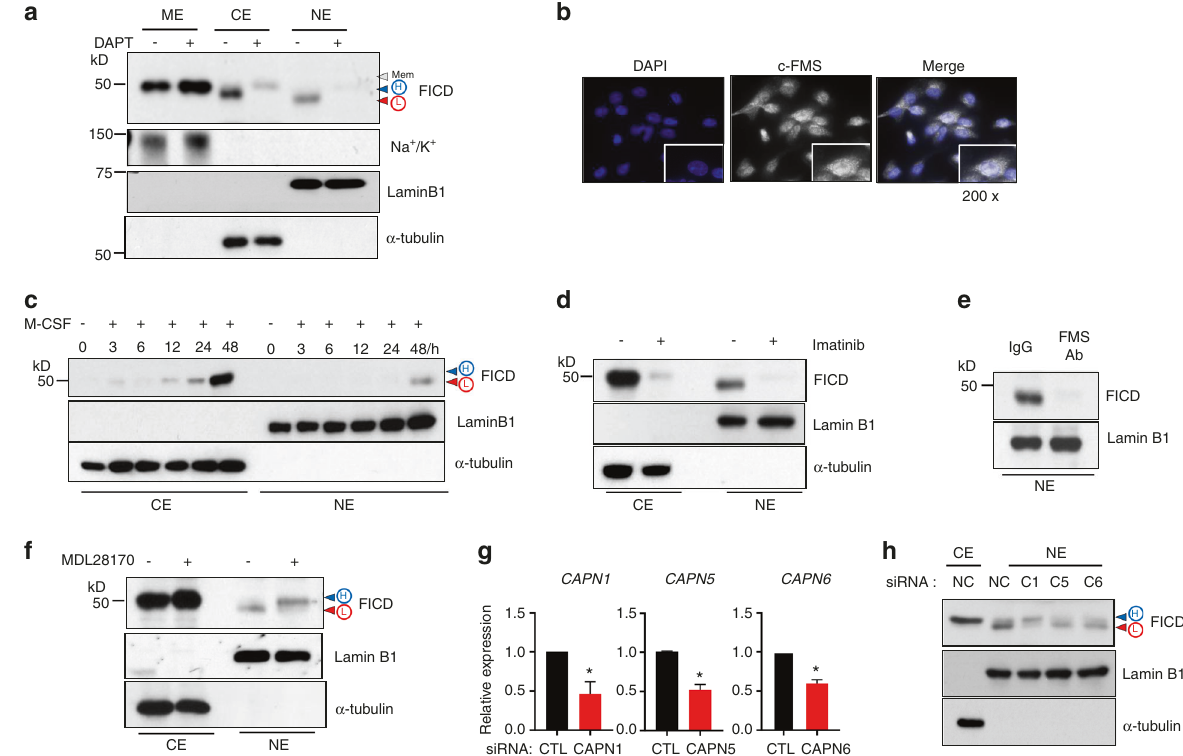
Fig. 2 Calpain 1 cleaves FICD fragments. a Human CD14 + cells were cultured with M-CSF (20 ng·mL − 1 ) for 8 h to induce early signals, and then DAPT (10 μ mol·L − 1 ) was added. The cells were cultured for additional 2 days. Protein expression of c-FMS, the Na + /K + pump, Lamin B1, and α - tubulin were determined by immunoblot analysis. ME membrane extracts, CE cytoplasmic extracts, NE nuclear extracts. b Immunocytochemical analysis of DAPI and c-FMS. The right panel shows a merged image. Scale: 200×. c Cells were starved for 3h and then stimulated with M-CSF for the indicated times. d , e Cells were treated with imatinib (0.3 μ mol·L − 1 , d or a c-FMS-blocking antibody (5 μ g·mL − 1 , e prior to the addition of M-CSF. Protein expression of the FICD was measured by immunoblot analysis. Lamin B1 and α -tubulin were used as controls for the nuclear and cytoplasmic fractions, respectively. f Human CD14 + cells were cultured with M-CSF (20 ng·mL − 1 ) for 8h to induce early signals, and then MDL 28170 (5 μ mol·L − 1 ) was added. The cells were cultured for additional 2 days. Immunoblot analysis with anti-c-FMS, Lamin B1, and α -tubulin antibodies. g , h Calpain 1, 5, and 6 were knocked down with siRNAs. The cells were cultured with M-CSF for 12 h. g Ef fi ciency of Calpain 1, 5, and 6 knockdown. h Immunoblot analysis of c-FMS, α -tubulin, and Lamin B1. All data are shown as the mean ± SEM. * P < 0.05 by two-tailed, unpaired t -test ( g ). Representative results from at least three independent experiments are